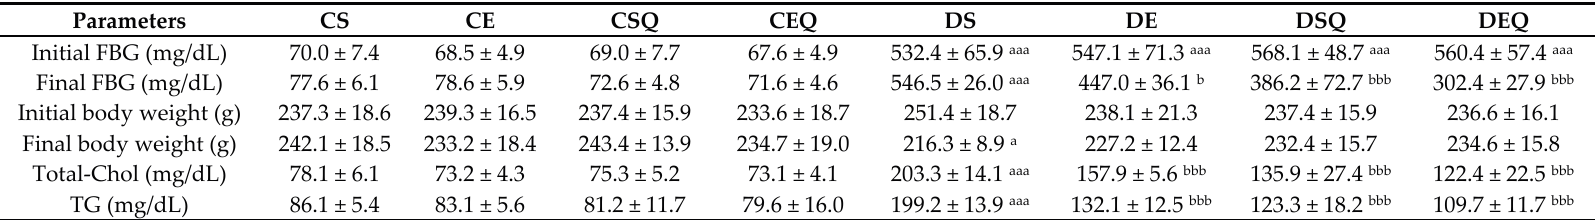
Table 1. The effect of quercetin and moderate exercise training on fasting blood glucose, body weight, fasting plasma total cholesterol and triglyceride levels in experimental